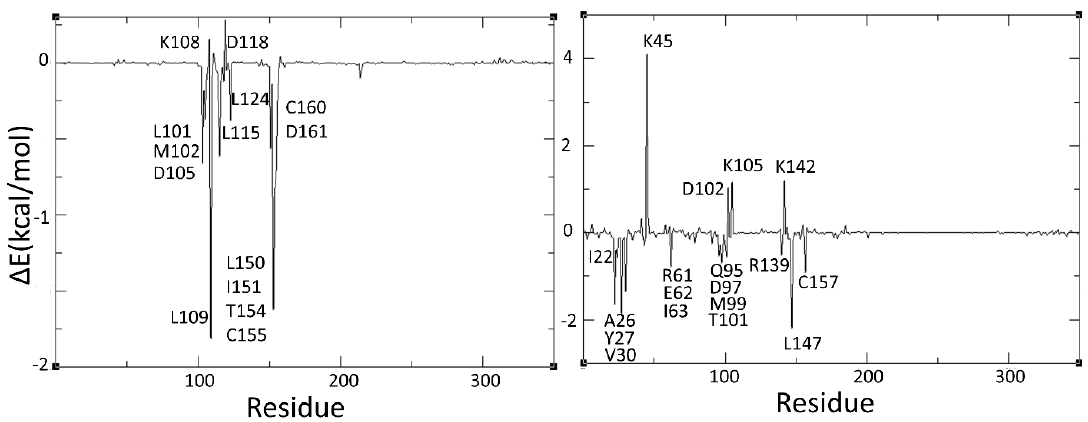
Figure 9. Per-residue decomposition profiles of ERK1-H1 ( left ) and ERK2-H1 ( right ) complexes. Such analyses reveal that the interactions of H1 with ERK-2 is favoured by residues such as Ile22, Ala26, Tyr27, Val30, Arg61, Glu62, Ile63, Gln95, Asp97, Met99, Trp101, Arg139, Leu147 and Cys157,